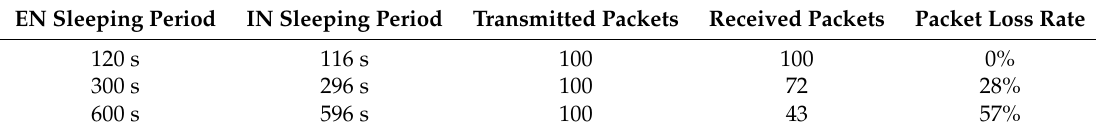
Table 2. Multi-hop data transmission. Packet loss rate in different